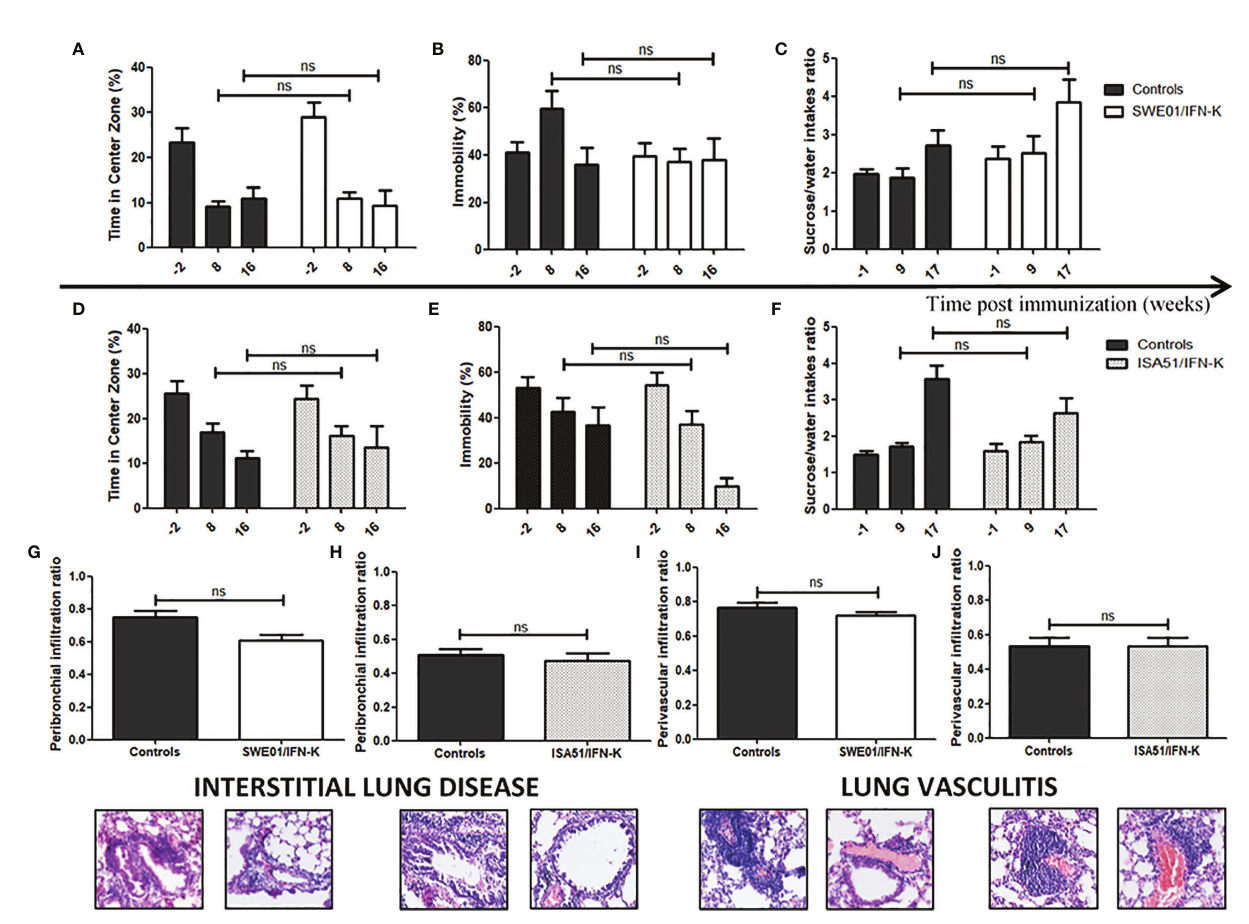
FIGURE 7 | Unaffected features of systemic Sjögren ’ s syndrome in MRL/lpr mice. (A, D) Anxiety-like (leading to a reduction of the time spent in the center zone in the open fi eld) and (B, E) depression-like (leading to a higher degree of immobility in the forced swim test) behaviors were assessed 2 weeks before immunization (n=26 in both cohorts), 8 weeks (n=26 in both cohorts) and 16 weeks (n=21 in SWE01 cohort and n=25 in ISA51 cohort) post-immunization with (A, B) SWE01 or (D, E) ISA51 as adjuvant. (C, F) Anhedonia, leading to a reduction in sucrose/water intakes ratios, was assessed before immunization (-1 week; n=26 in both cohorts), 9 weeks (n=25 in SWE01 cohort and n=26 in ISA51 cohort) and 17 weeks (n=20 in SWE01 cohort and n=25 in ISA51 cohort) post-immunization. Lungs were harvested for all living mice (n=20 in SWE01 cohort and n=25 in ISA51 cohort) at the time of sacri fi ce (D+122), to evaluate the extent of their pulmonary disease. (G, H) The peribronchiolar in fi ltration ratio (i.e. the number of medium to large bronchioles surrounded by in fl ammatory cells over the total number of medium to large bronchioles on each slide) and the (I, J) perivascular in fi ltration ratio (i.e. the number of medium to large vessels surrounded by in fl ammatory cells over the total number of medium to large sized vessels on each slide) were calculated to quantify the degree of interstitial lung disease and lung vasculitis, respectively. Representative images of hematoxylin and eosin stained sections are shown (original magni fi cation x40). No IFN-K-related effect was observed when comparing the treated mice and their controls (NT, PBS and KLH mice). Error bars indicate mean ± S.E.M. Ns p >